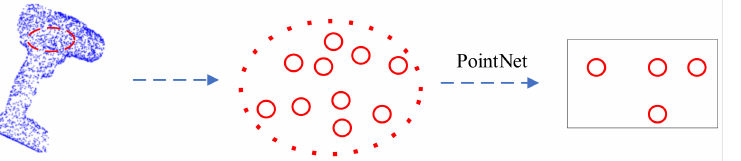
Figure 1. Hierarchical point cloud feature learning method. Point cloud subsets are generated in the aggregation layer through random sampling, and abstract local features can be extracted after multiple